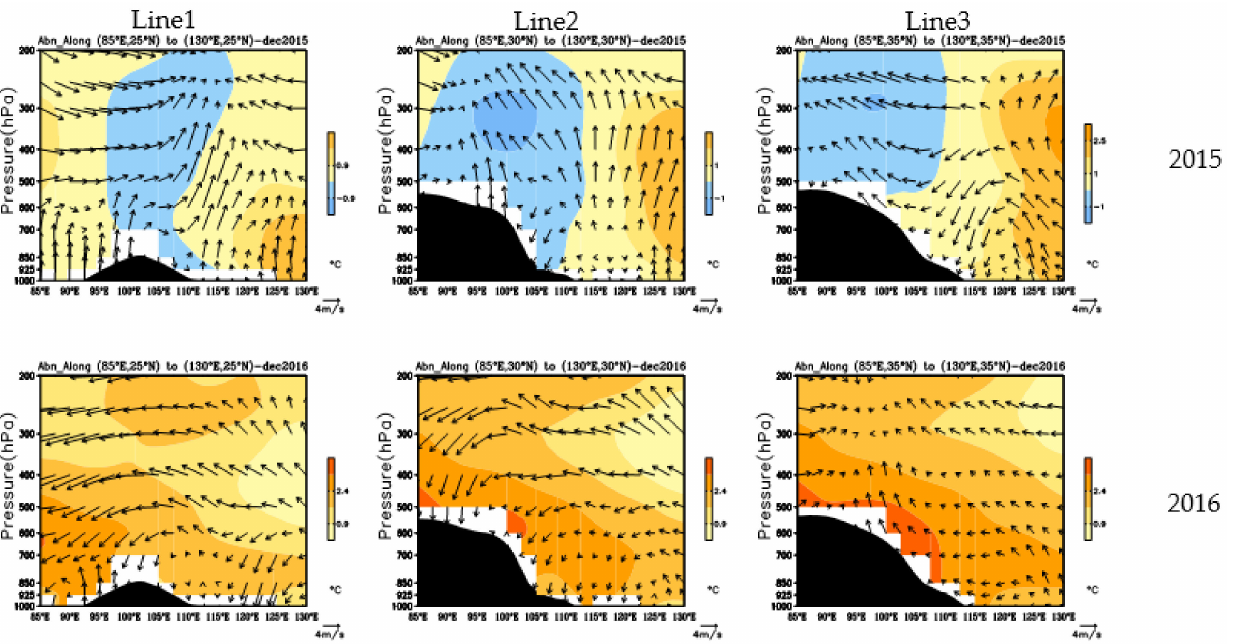
Figure 8. East–west circulation and temperature cross sections of profile 1 ( left ), profile 2 ( middle ) and profile 3 ( right ) in the 2015 ( top ) and 2016 ( bottom ) weak cold source–weak winter monsoon